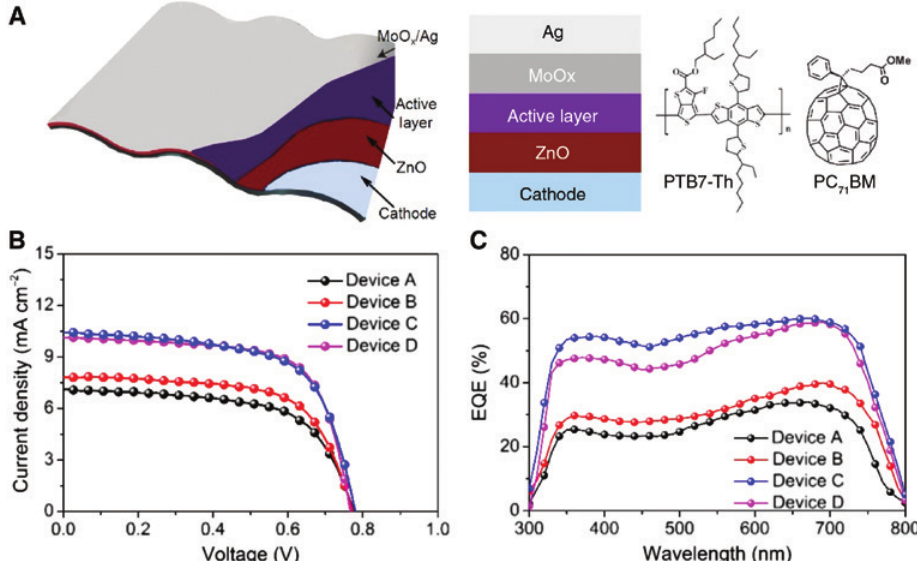
Figure 3: FOSC characteristics. (A) Schematic illustrations of a top-illuminated FOSC and the molecular structure of the active materials used in this study. (B) J–V characteristics and (C) external quantum efficiency (EQE) spectra measured for the top-illuminated FOSCs made with different bottom electrodes of bare graphite (Device A), Ag (0.5 nm)-modified graphite (Device B), Ag (1 nm)-modified graphite (Device C), Ag (2 nm)-modified graphite (Device D).